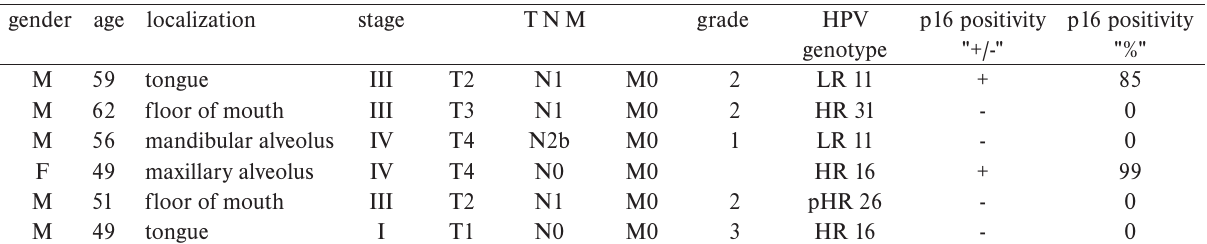
Table 2. Baseline characteristics of patients with HPV positive